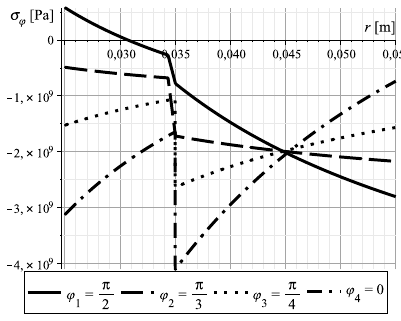
Figure 14: Plot of U ( φ ) (Example 5.2).